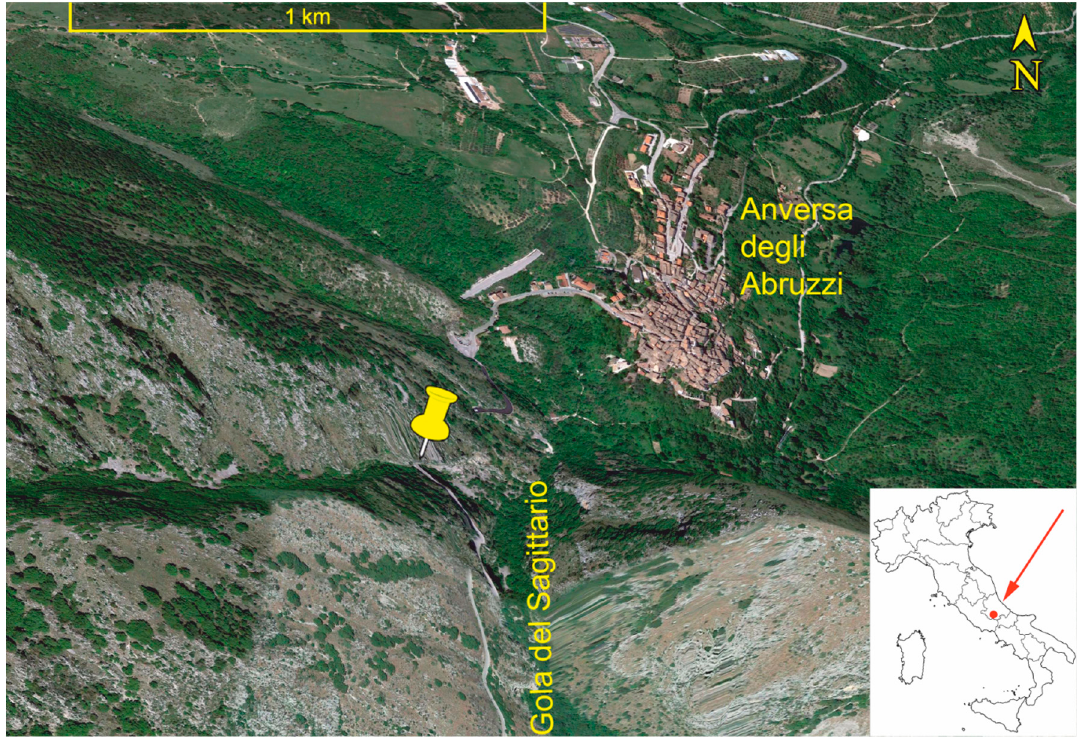
Figure 1. Geographic positioning of Gola del Sagittario within the Italian Peninsula (inset map) and location of the Ephedra major seed sampling site (yellow pin). Source: Google Earth Pro imagery shot on the 13 June 2022.